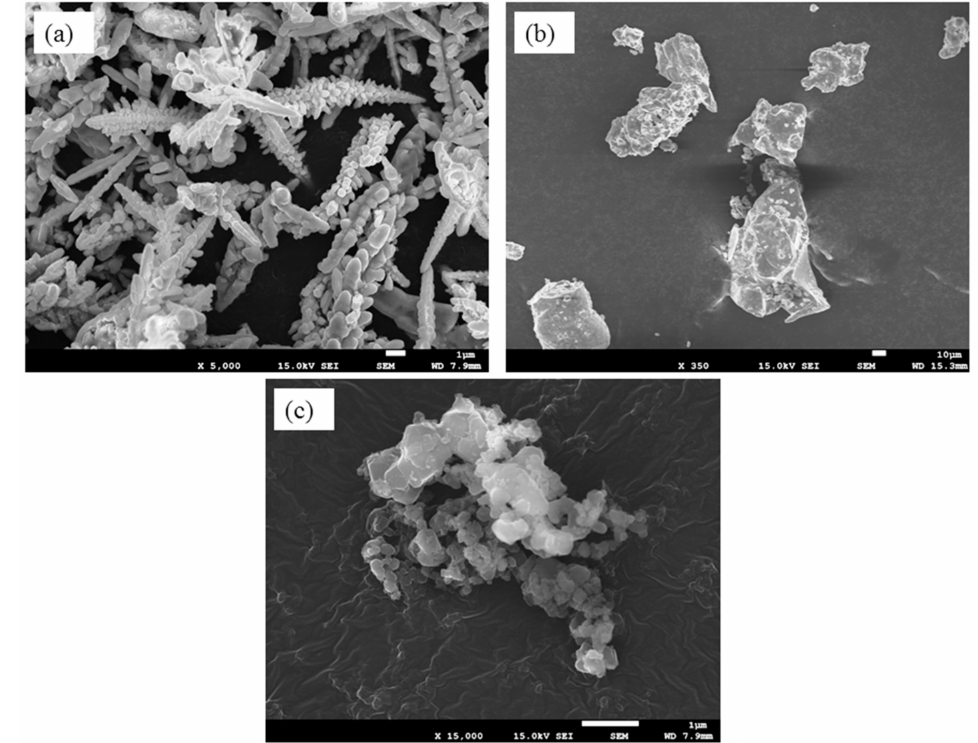
Figure 3. SEM micrograph of ( a ) as-received Cu, ( b ) Ti, and ( c ) B powder.